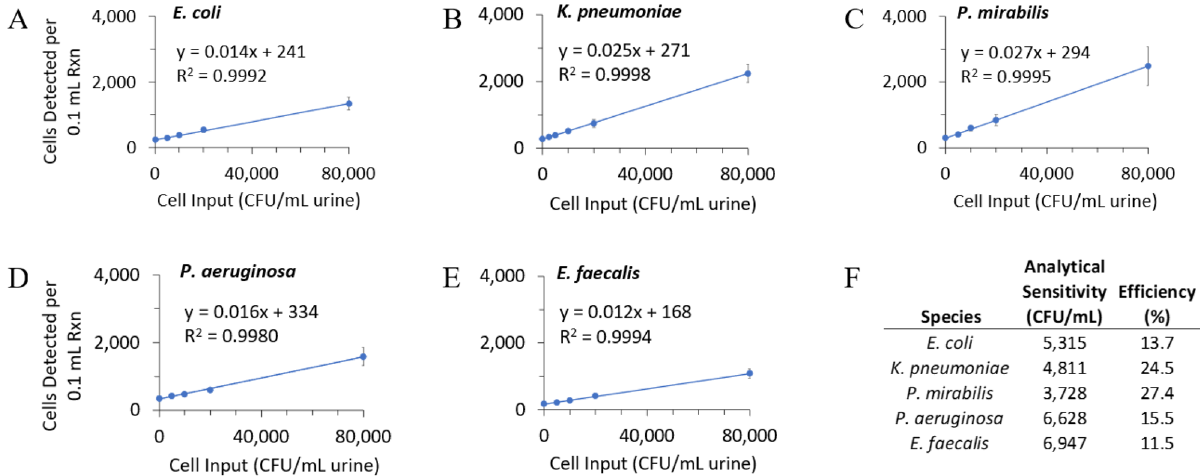
Figure 4. Correlation between MultiPath signal and input cells. Bacterial cells were added to pooled urine from 0 to 80,000 CFU/mL, processed by rapid SEC, added to test cartridges, and automatically processed on the MultiPath analyzer. ( A – E ) Ordinary least squares regression models and coefficients of determination for 5 MultiPath bacterial assays as indicated. Input cell concentrations were estimated from OD 600 measurements of broth cultures prior to dilution in urine. Plotted data points are means of 6 or 7 replicates per cartridge and 3–5 processed cartridges per species. Error bars are plus/minus one SD and in many cases are too small to be seen. ( F ) Analytical sensitivity and assay efficiency for each of the 5